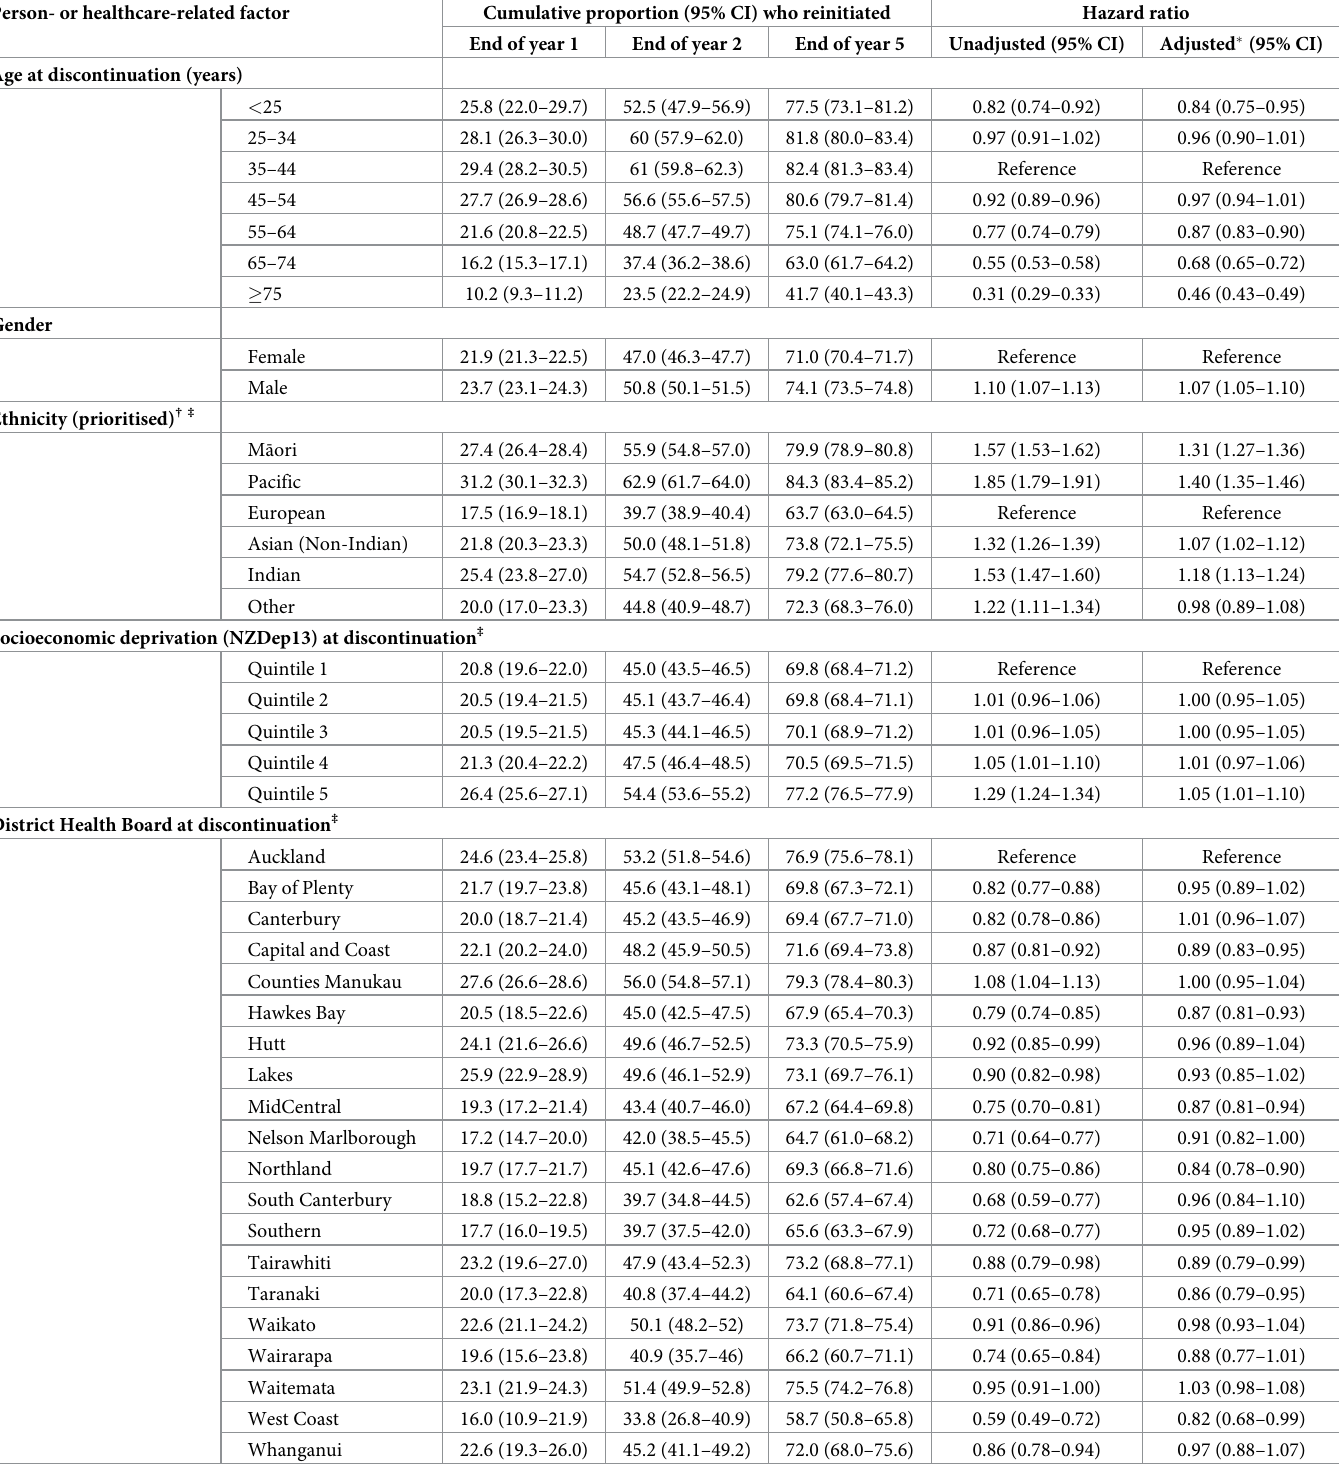
Table 2. Comparison of cumulative proportions who reinitiated metformin monotherapy after first discontinuation by person- and healthcare-related